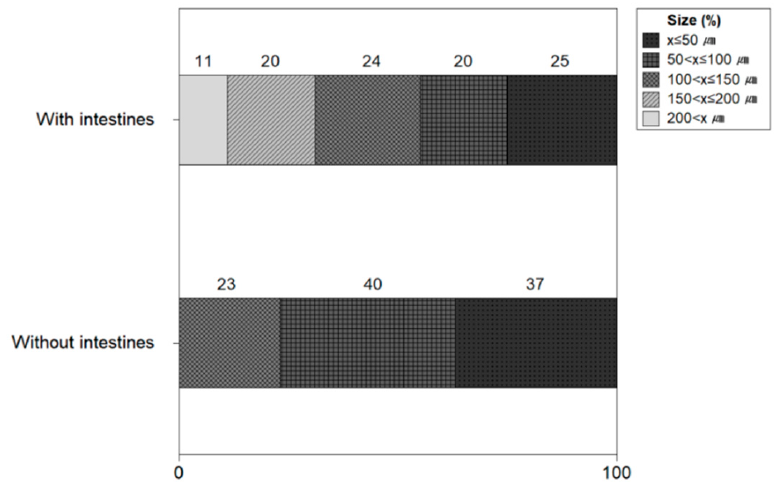
Figure 11. Size of microplastics with and without intestines and heads of shrimps. heads. The microplastic color of the shrimp with intestines and heads was confirmed in the following order: blue (60%), white (12%), black (8%), green (8%), red (3%), yellow (3%), and gray (1%). In shrimp without intestines and heads, microplastics were identified in the following order: blue (62%), white (17%), green (9%), black (7%), red (3%), and yellow (1%). Blue was the main color of microplastics in shrimp with intestines and heads and shrimp without intestines and heads, and there was no significant difference in other